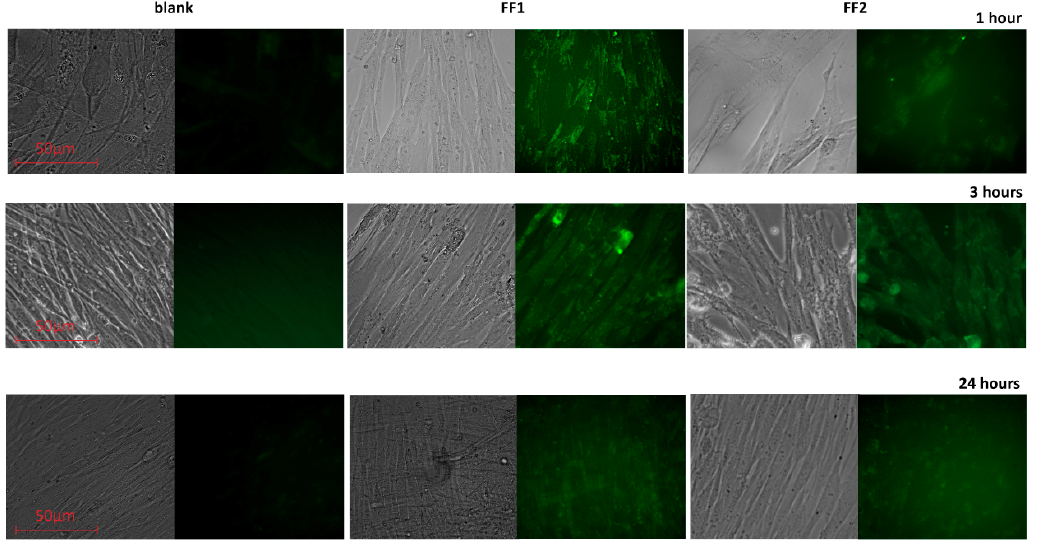
Figure 5. Fluorescence of FF1 and FF2 (1.3 µ M) in cells for 1, 3 and 24 h of incubation: for each pair, the left image is transmitted light, the right image is the fluorescence of the compounds with a 450–525-nm filter; excitation wavelength 370 nm; magnification, × 40. In blank experiments, cells were incubated without the fullerenes.